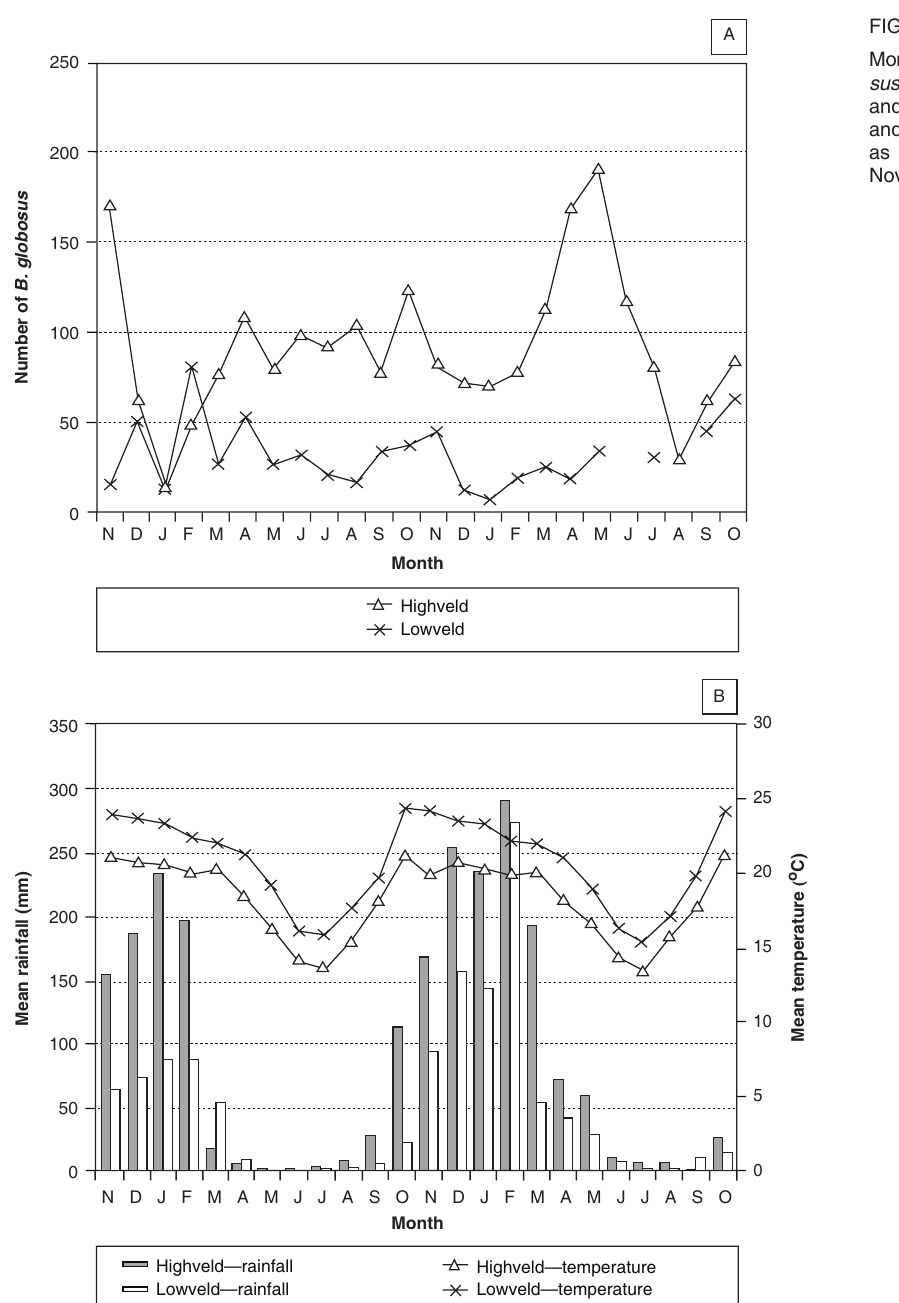
in the highveld. However, significantly higher num- bers of B. globosus were collected from highveld dams ( P < 0.01) than lowveld dams. There was a pos itive correlation between the mean number of snails collected and the plants Typha spp. ( r = 0.64) and Nymphaea caerulea ( r = 0.58). The seasonal distribution of B. globosus is shown in Table 6 . In the highveld, significantly ( P < 0.01) lower mean numbers were collected during the rainy sea-